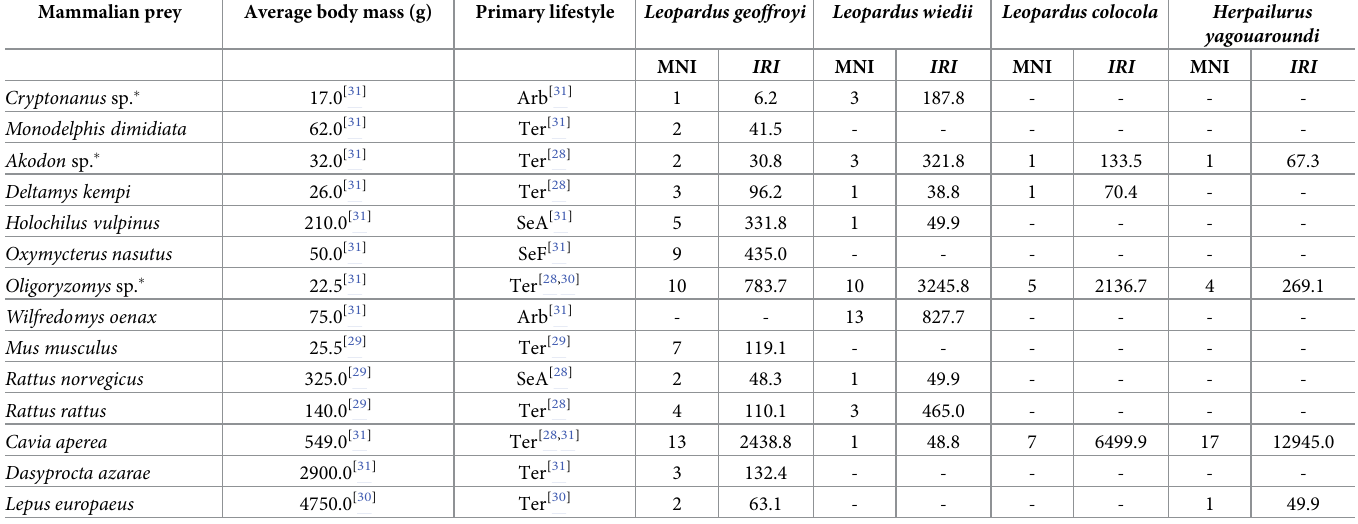
Table 3. Mammalian prey species’ contribution to the diet of four small sympatric cats in Brazilian Pampa. Mammalian prey